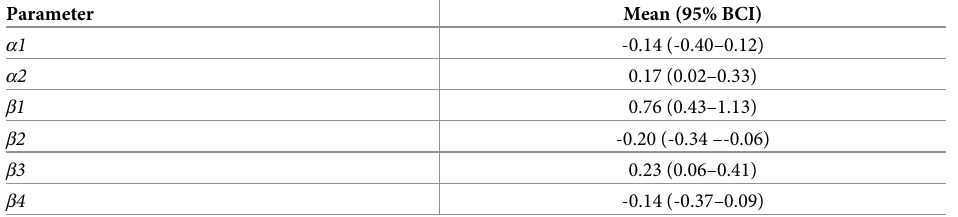
α 1 and β 1 = parameters for species body mass (log-transformed); α 2 and β 3 = distance to human settlements; β 2 = distance to nearest river; β 4 = moist forest